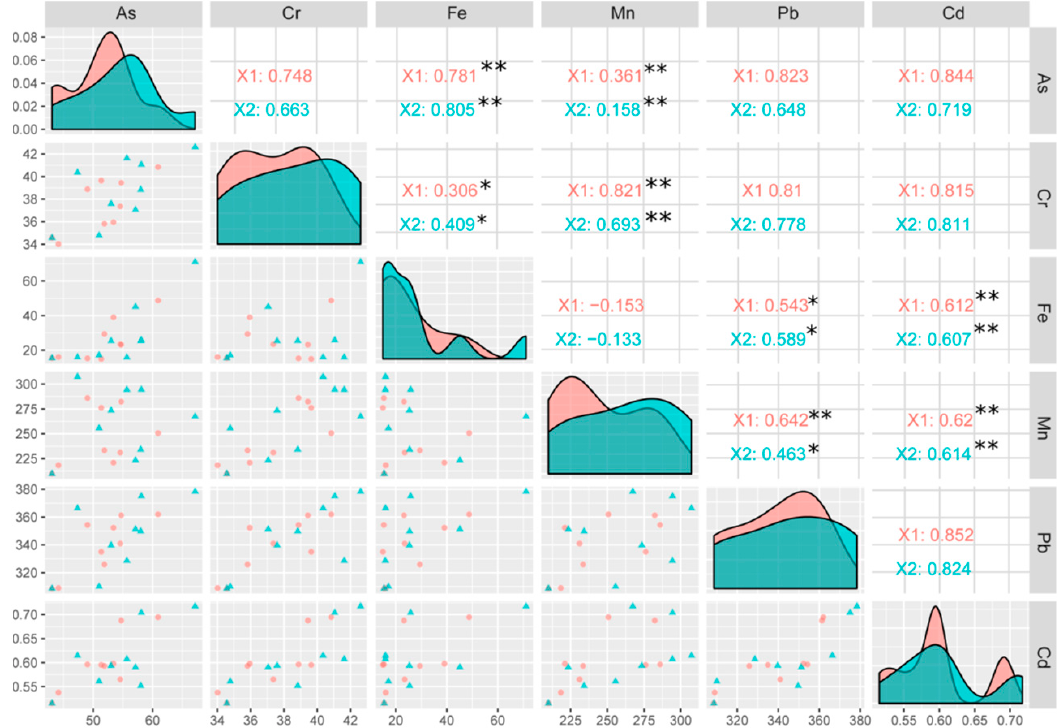
Figure 5. Correlation between extractable content of different element concentrations in soil.